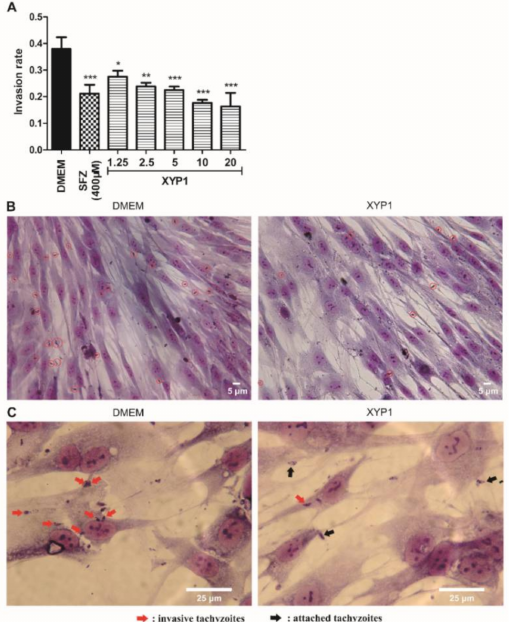
Figure 3. Effects of XYP1 on the invasion of T. gondii tachyzoites. Tachyzoites were pre-treated with DMEM (the negative control), SFZ (the positive control), and two-fold serial dilutions of XYP1